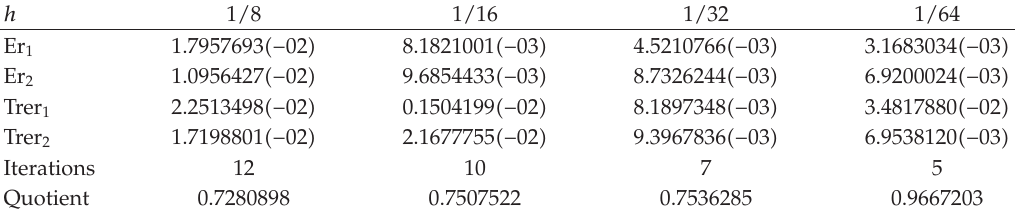
Table 1: Results on the square without a posteriori estimates as a stopping criteria for the first example. h 1 / 8 1 /